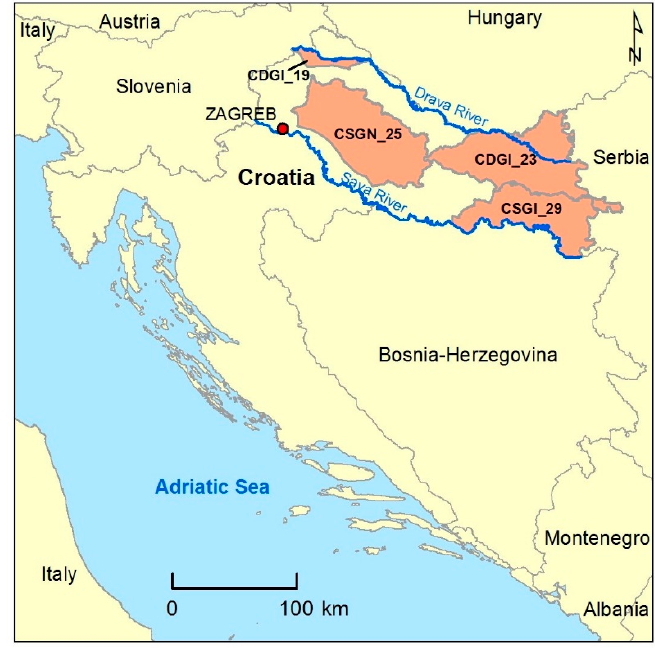
Figure 1. Location of the investigated groundwater bodies in Croatia.